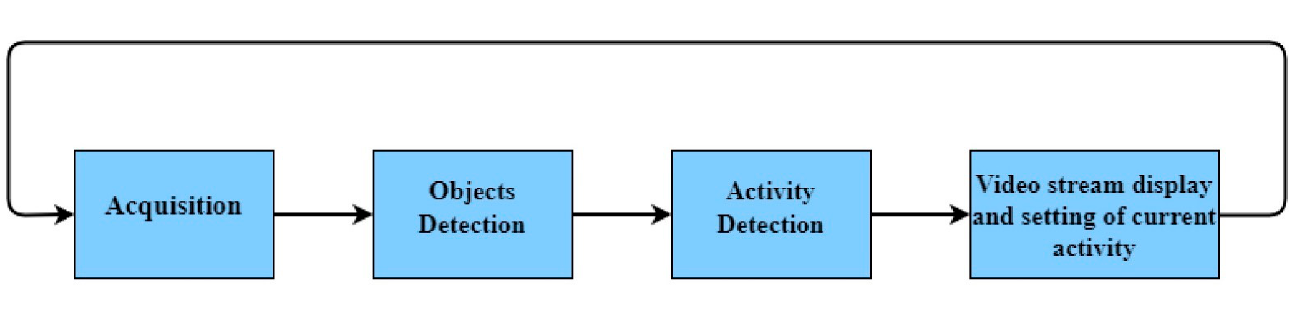
Figure 15. Sequential configuration: single thread for acquisition, object detection and activity detection.